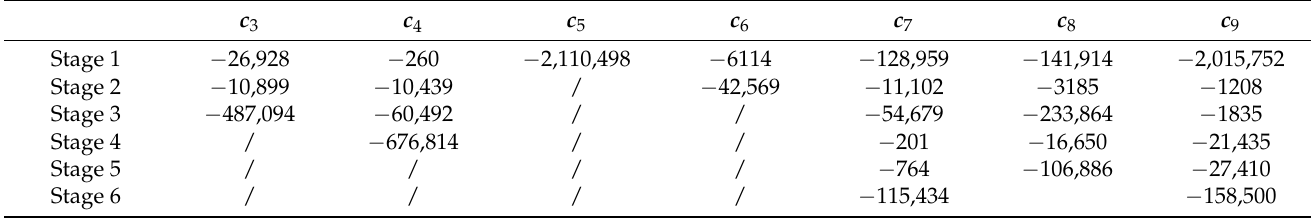
Table 6. Values of fitness function at different stages of the Wine quality-white data